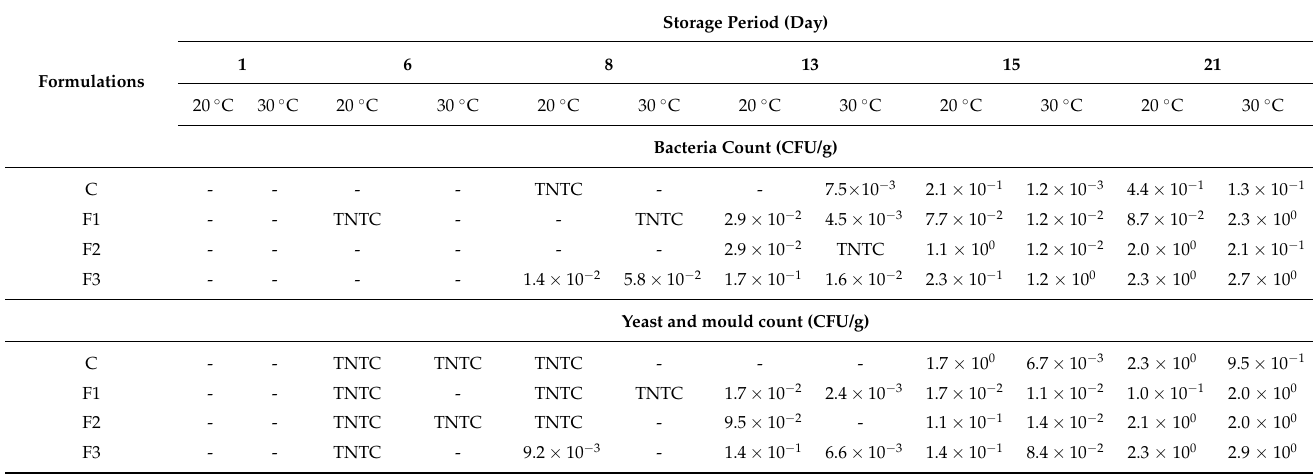
Table 8. Bacteria, yeast, and mould count of control and GABA-enriched dark chocolates. Storage Period Formulations